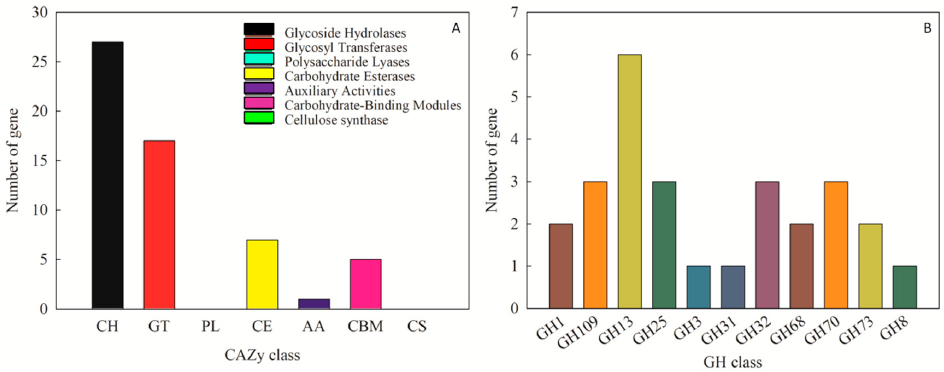
Figure 7. CAZy annotation of Leu. mesenteroides DRP105 (( A ): CAZy annotation; ( B ): glycoside hydrolases (GH) family annotation).